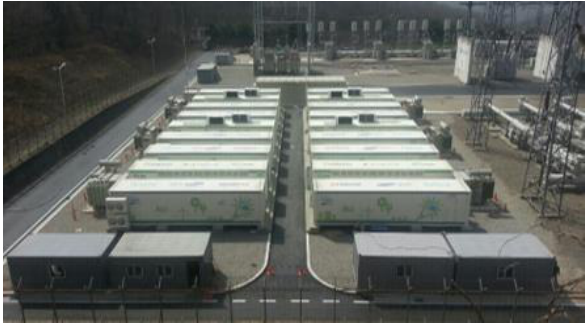
Figure 2. Substation installed with energy storage device for frequency regulation (24 MW).